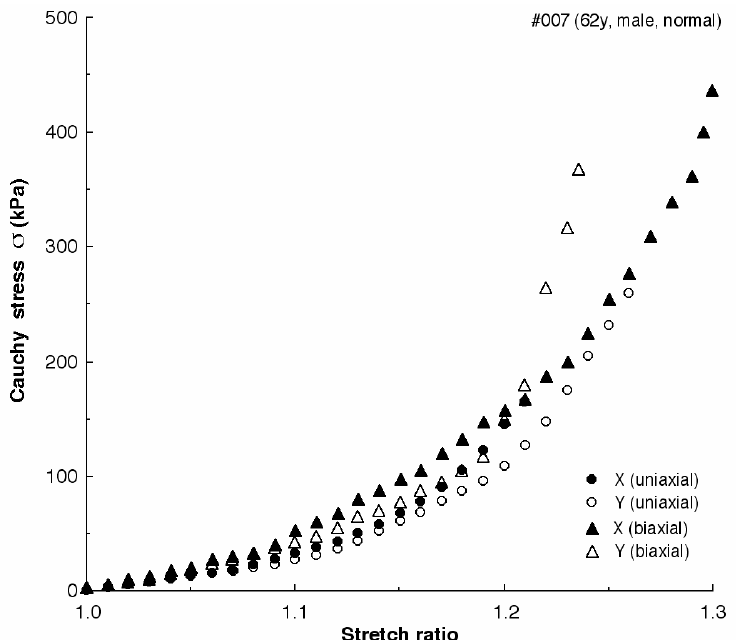
Fig. 4 Comparison of stress-stretch ratio curves obtained in the biaxial and uniaxial tensile test. Table 3 Comparison of the initial elastic moduli (kPa) obtained from the present biaxial and the conventional uniaxial tests. Biaxial test Uniaxial